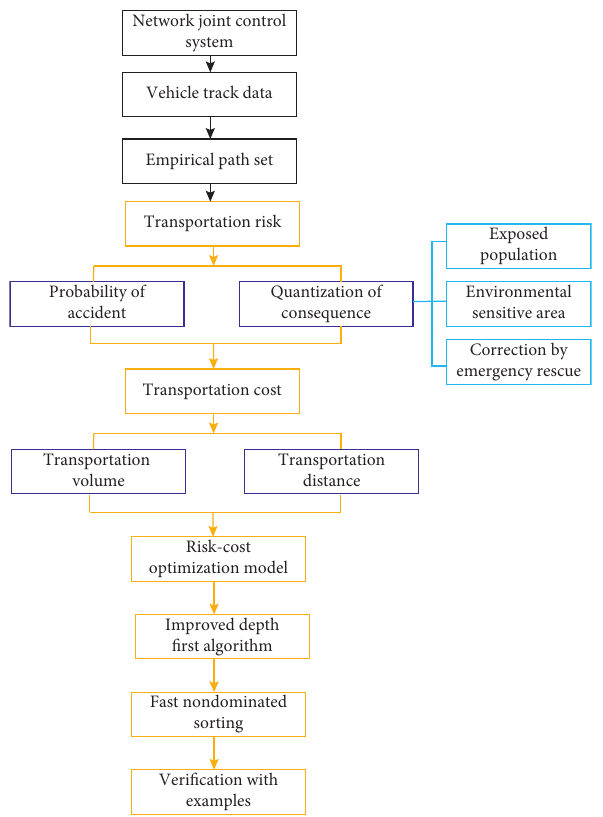
Figure 1: The flow chart t based on the proposed research